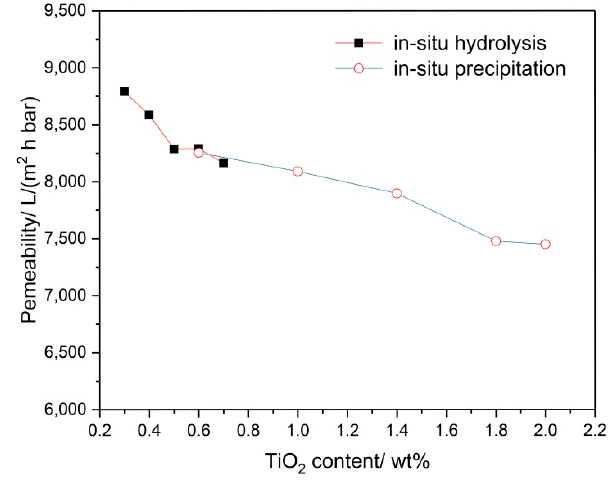
Figure 10. Water permeability of the supports with different contents of TiO 2 added.